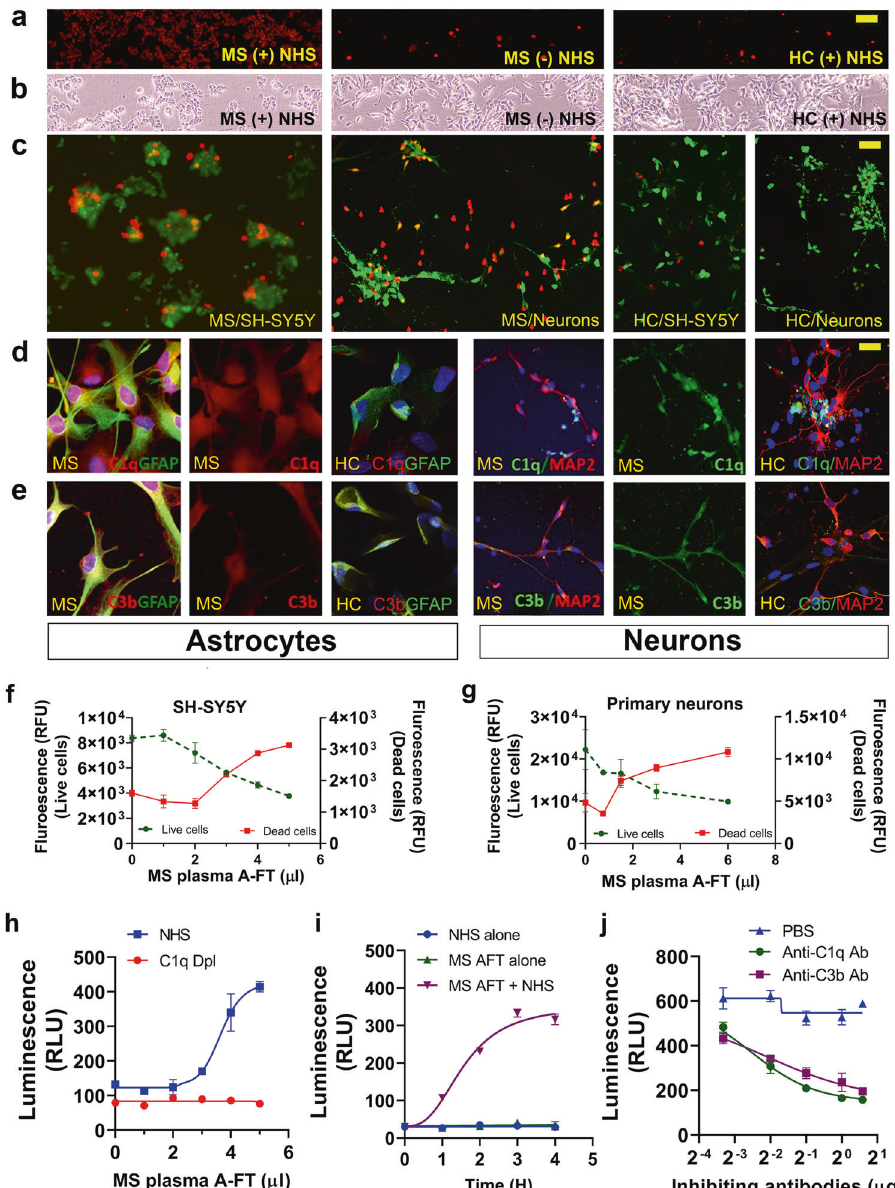
Fig. 2 MS plasma A-FT induces complement activation and neuronal cell death. a , b Normal human serum (NHS) is required for MS A-FT cytotoxicity. SH-SY5Y cells were treated with MS or HC A-FT for 4 h in the presence of propidium iodide followed by live-cell imaging. Fluorescent ( a , left panel) and phase contrast imaging ( b , left panel) showed a massive number of dead cells in wells incubated with MS A-FT plus NHS, and few dead cells in wells without NHS [MS (-) NHS] (middle panels). HC A-FT treated cells [HC ( + ) NHS] revealed few dead cells (right panels). Scale bar, 100 µm. c LIVE/DEAD ™ Viability/Cytotoxicity assay demonstrates neuronal damage caused by MS plasma A-FT, but not by HC plasma A-FT, in SH-SY5Y and primary human neurons. Viable cells are shown in green and dying and dead cells are in red. Scale bar, 50 µm. d , e Confocal microscopy demonstrates the presence of complement activation components C1q and C3b in astrocytes and neurons. Cells were treated with MS A-FT for 2 h, followed by double immunostaining for C1q and C3b and cell markers (GFAP for astrocytes and MAP2 for neurons). Scale bar, 20 µm. f , g Dose-response curves of total live and dead cells treated with MS A-FT for 4 h in SH-SY5Y cells ( f ) and human primary neurons ( g ) overnight. h Incubation of MS A-FT with C1q-depleted serum (C1q Dpl) produced no cytotoxicity in SH-SY5Y cells. i Treatment of NHS alone or MS A-FT alone did not induce apoptosis; only MS A-FT plus NHS caused neuronal death. j MS A-FT-produced apoptosis was inhibited by anti-C1q and anti-C3b antibodies in a dose-dependent manner. The apoptotic cell death was measured by luminescence after 4 h of treatment. Assay to assess apoptosis by measuring the real-time exposure of (Fig. 2d, e). We further quanti fi ed cell death in MS A-FT treated phosphatidylserine via luminescence signals. MS A-FT induced neurons using live/dead assays from data re fl ective of the images strong apoptosis in neuroblastoma (Fig. 2h, i). To de fi nitively in Fig. 2c. Dose-response curves of neuroblastoma/SH-SY5Y cells con fi rm if C1q is required for MS A-FT induced cytotoxicity, we (Fig. 2f) and primary neurons (Fig. 2g) demonstrated a higher showed that neurons incubated with MS A-FT plus C1q-depleted number of dead cells and a lower number of viable cells after MS human serum (C1q Dpl, Fig. 2h) or NHS alone (Fig. 2i) did not A-FT treatment. We applied RealTime-Glo ™ Annexin V Apoptosis